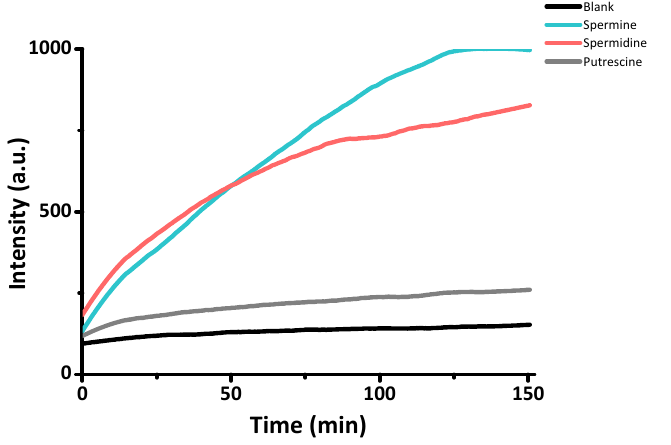
Figure 5. Rhodamine 6G ( λ em = 550 nm, λ ex = 525 nm) delivery profiles from S1 particles in the absence and presence of Spm, Spd, and putrescine.